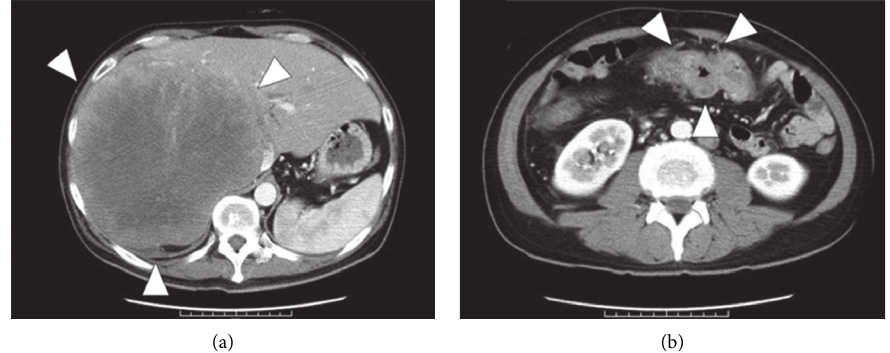
Figure 3: Contrast-enhanced CTscan to determine the primary site of neuroendocrine carcinoma of the thyroid. Tumors were found in the liver (A) and transverse colon (B).